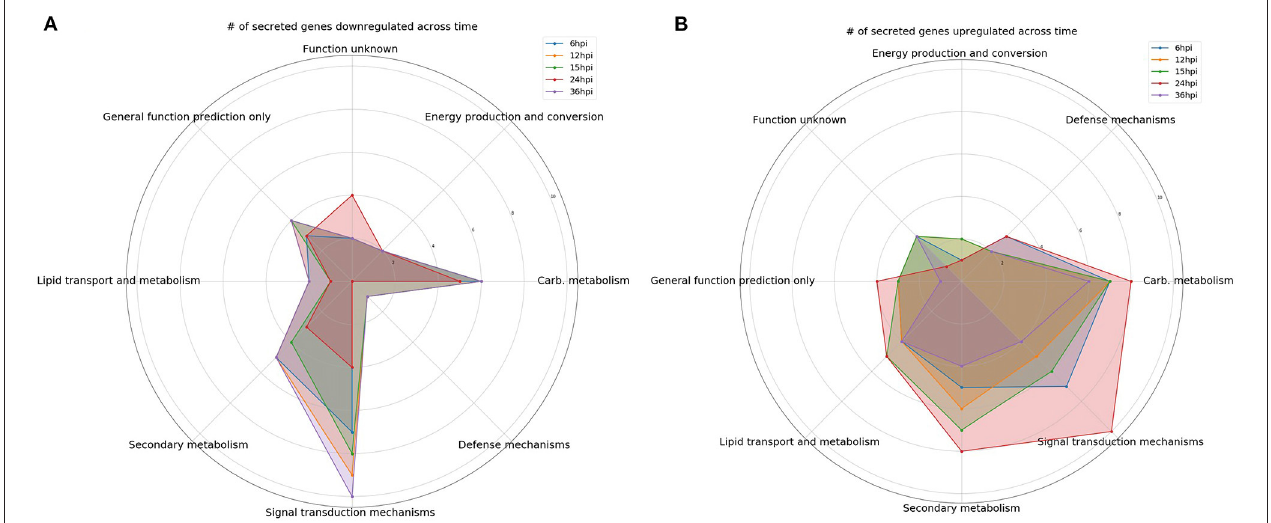
FIGURE 1 | Comparison over time of the number of differentially expressed genes encoding predicted secreted proteins. Gene categories were selected based on perceived likelihood of involvement in the interaction between the fungus and plant. Each color corresponds to a different time point. (A) A radar plot of the number of downregulated genes over time. (B) A radar plot of the number of upregulated genes over